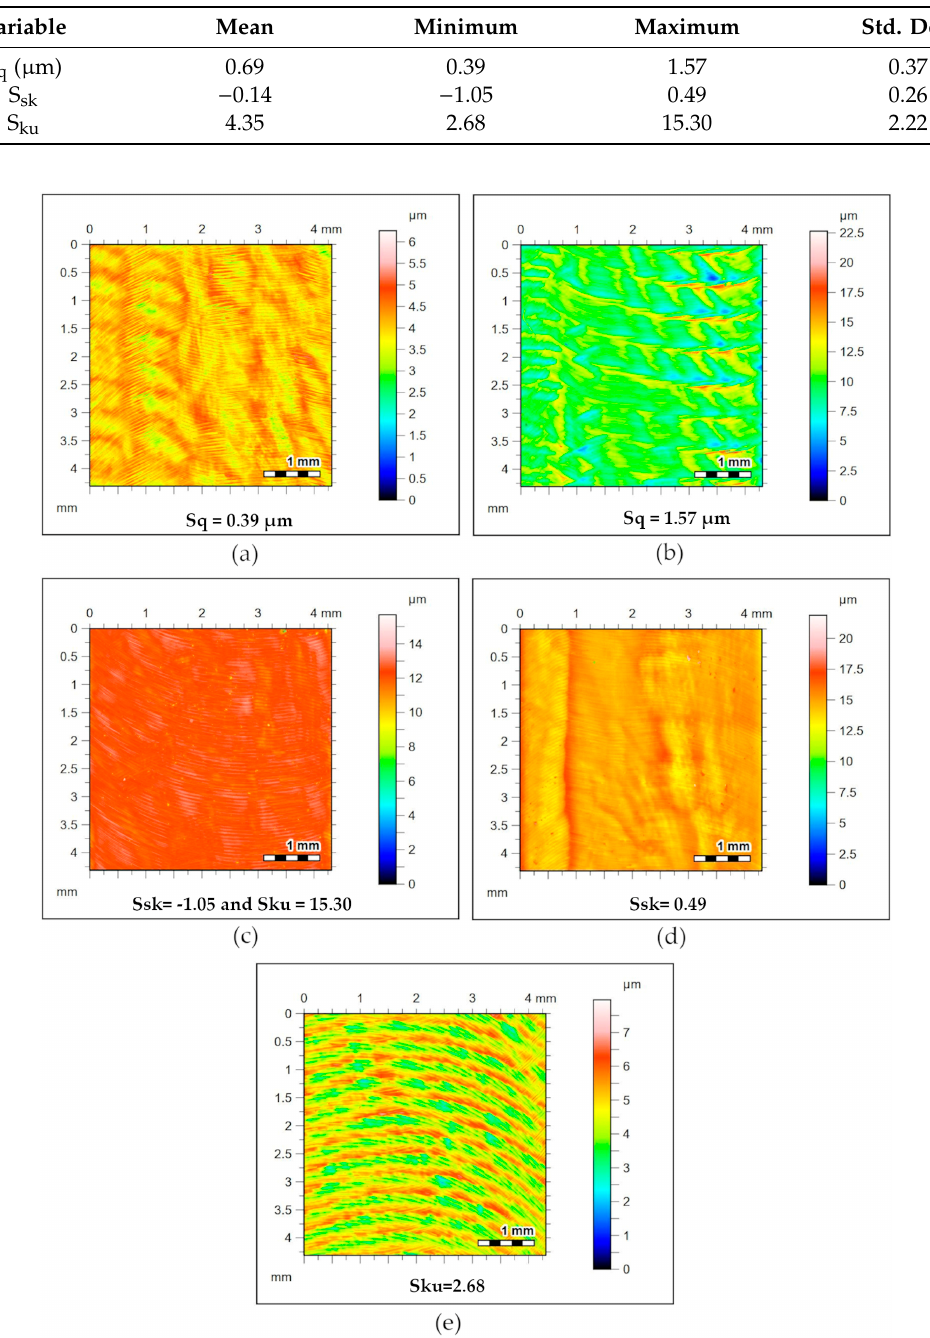
Figure 11. Sq, Ssk, Sku minimum and maximum milled surface topography parameter values measured. ( a ) S q = 0.39 µm; ( b ) S q = 1.57 µm; ( c ) S sk = − 1.05 and S ku = 15.30; ( d ) S sk = 0.49 µm; ( e ) S sk = 2.68 µ